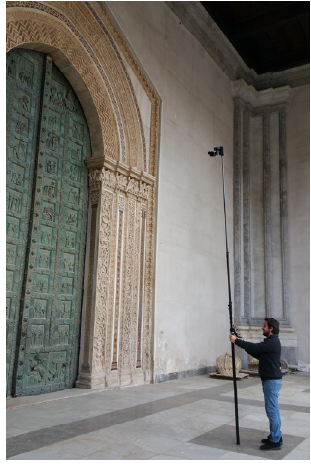
1.04 mm was obtained.